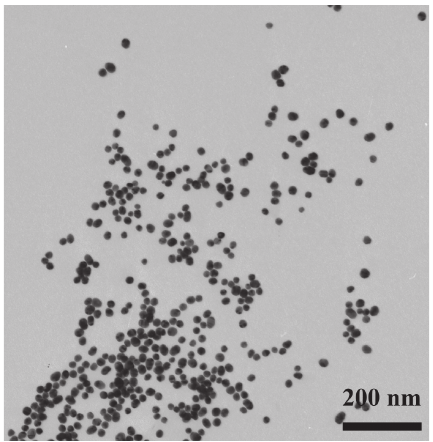
Figure 4: Electron microphotograph of GNPs.